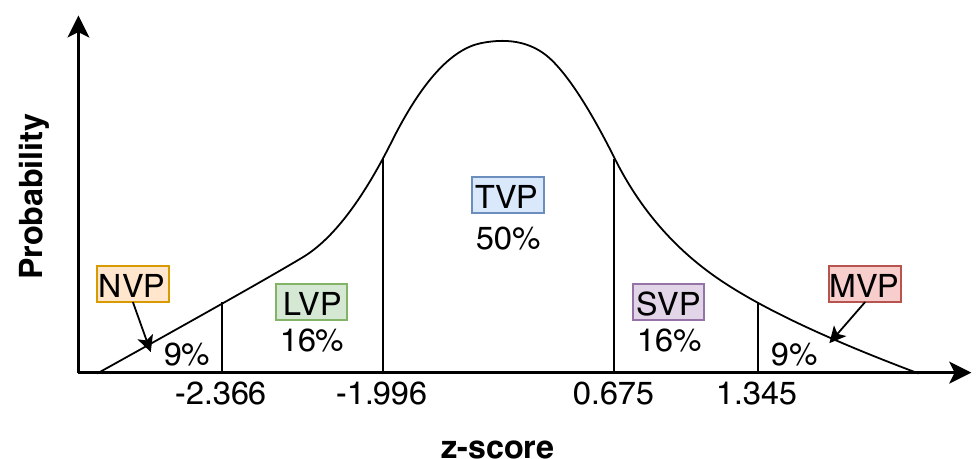
Figure 4. Allocation of agents to levels based on their